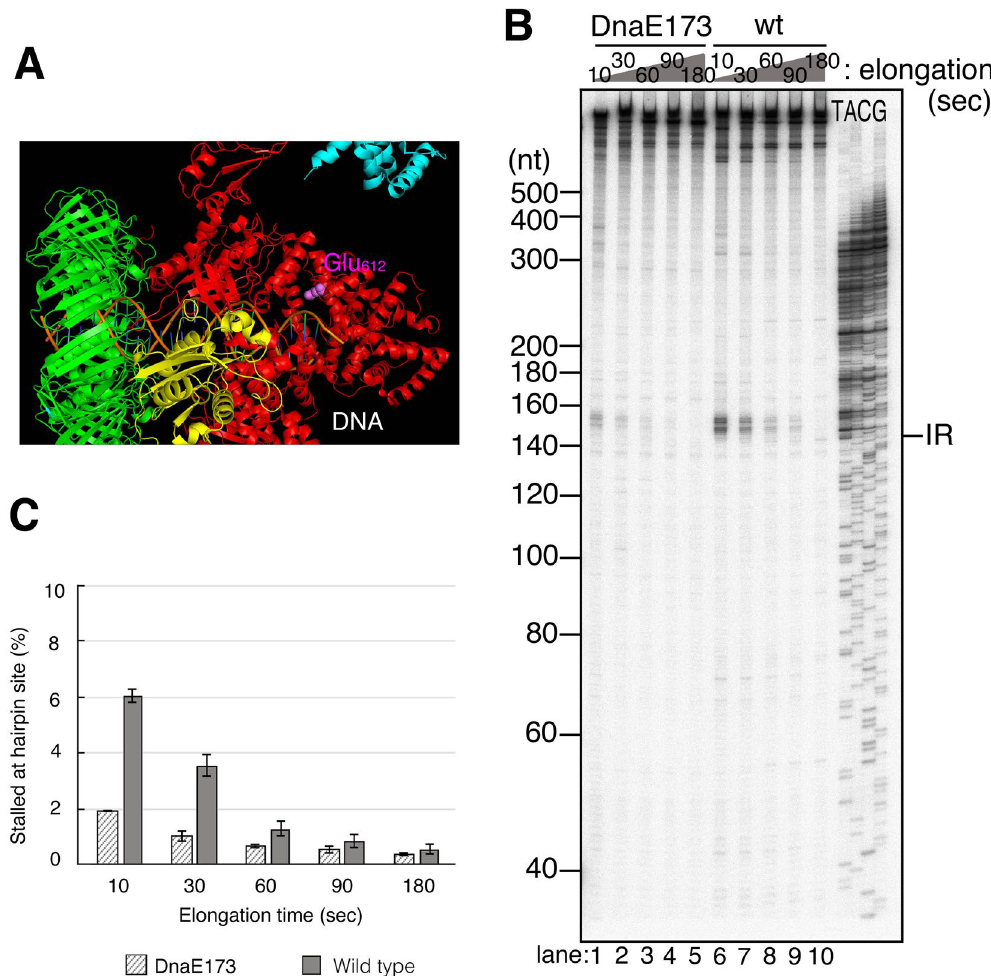
Figure 6. Pol III dnaE173 HE is more resistant than wild-type Pol III HE to Pol IV-mediated switching at the inverted repeat. ( A ) Structural model of Pol III α - ε on β -DNA complex showing the location of a mutation in dnaE173 (based on PDB 5fkv 33 , and created using MacPyMOL (DeLano Scientific LLC)). Glu 612 is shown as pink spheres. Subunits are shown as colored ribbons: α , red; ε , yellow; β , green: τ (partial), pale blue. ( B ) The effect of Pol IV on ongoing wild-type or mutant Pol III HE was tested on primed pMS2-aIR-23 in the time course experiment. Wild-type Pol IV was added to the reaction at a final concentration of 100 nM when the elongation reaction was initiated by the addition of dTTP. Replication products at indicated time points were analyzed as in Fig. 2B. ( C ) The amount of pausing products at the repeat relative to the total products each conditions in Fig. 6B were quantified. The percentages of stalled Pol III in the presence of 100 nM Pol IV at the repeat were calculated and the average of three independent experiments were shown with standard deviations